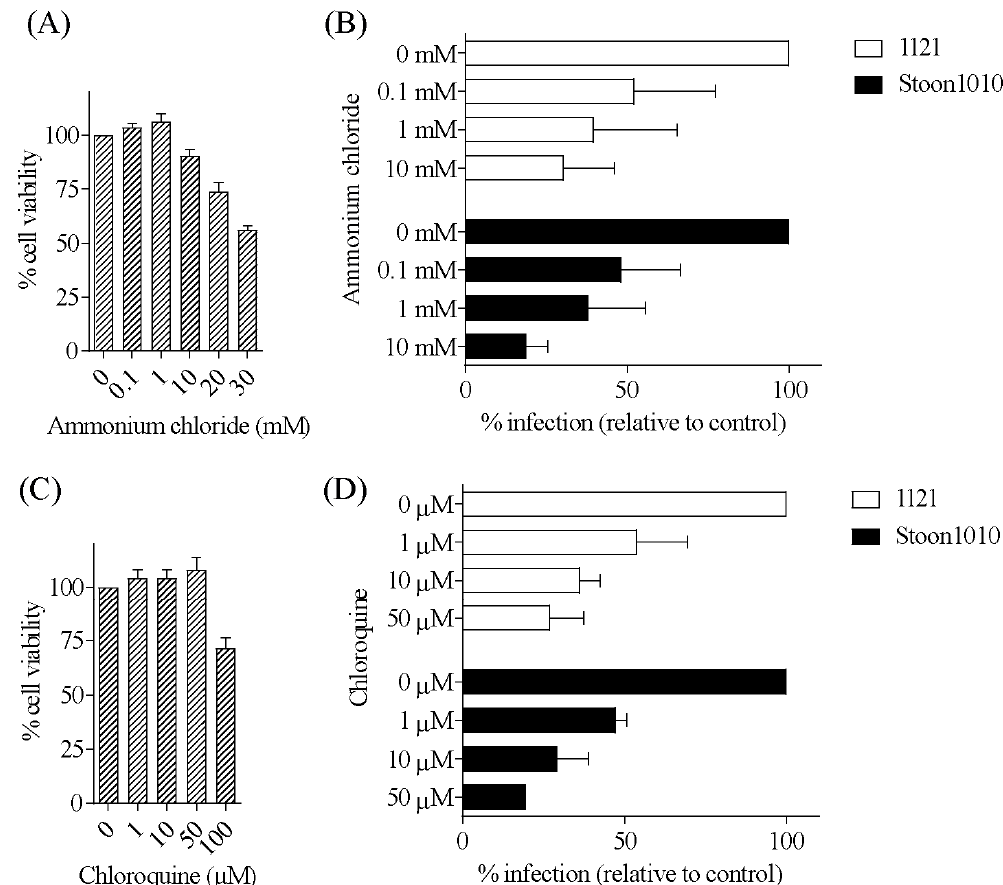
Figure 12. PCV2 infection of T-lymphoblasts requires a low-pH step. ( A , C ) Viability of cells treated with di ff erent concentrations of ammonium chloride ( A ) or chloroquine ( C ), as measured by MTT assay. ( B , D ) Cells were pre-treated with ammonium chloride (0, 0.1, 1, 10 mM) ( B ) or with chloroquine (0, 1, 10, 50 µ M) ( D ) prior to PCV2 infection. The percentage of PCV2-infected cells was quantified. The infection level in the treated group was expressed as the relative percentage to that of the control group (drug concentration = 0 mM). Data represent means ± SD of triplicate